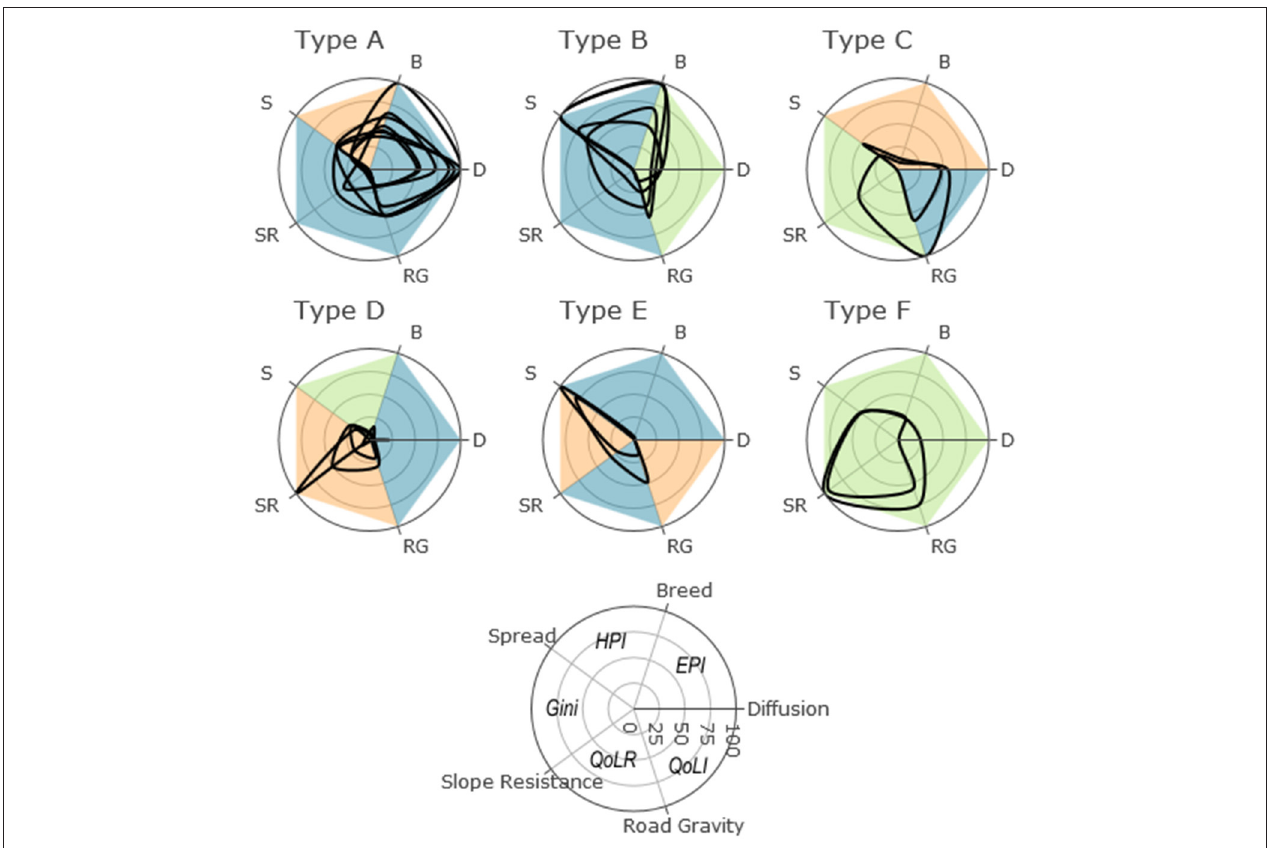
FIGURE 1 | Urban DNA mixture in each city type of the taxonomy. The black spider-web lines represent the DNA of the cities of each type; D, diffusion; B, breed; S, spread; SR, slope resistance; RG, road gravity. The colored background layers represent how each cluster manages in five indicators, starting from D counterclockwise: QoLI, QoLR, Gini, HPI, and EPI; orange: bottom, blue: middle, green: top of the